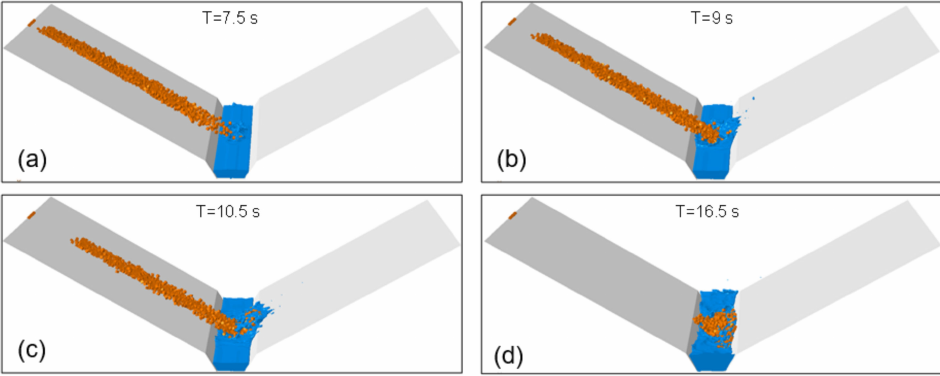
Figure 15. The propagation process of the impulse wave: ( a ) initial status; ( b ) development process; ( c ) maximum height; ( d ) dissipation